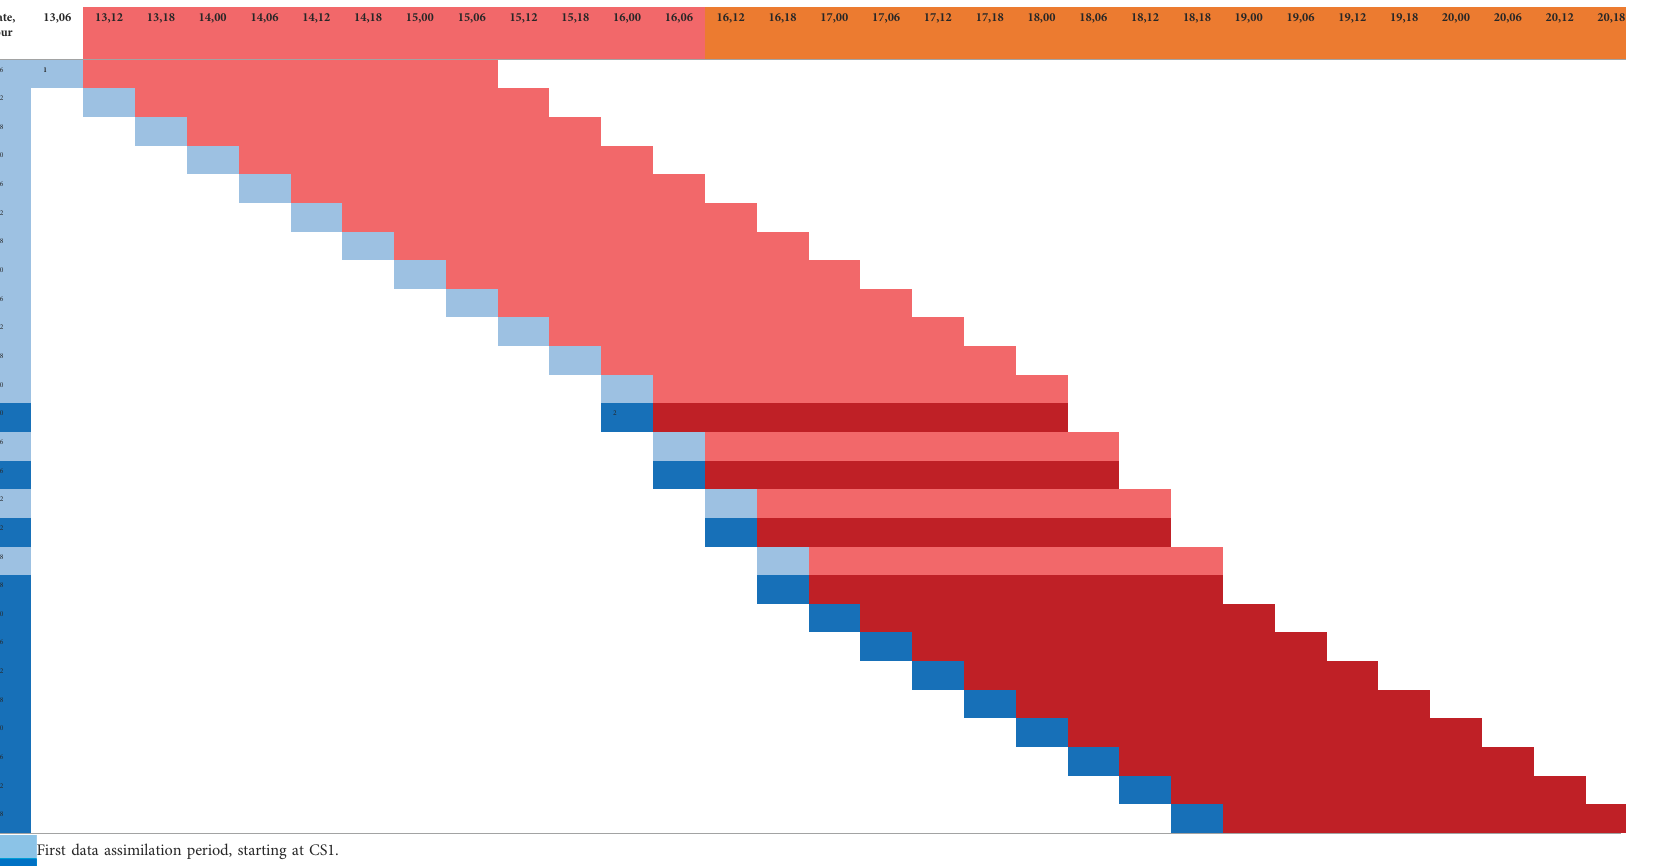
First data assimilation period, starting at CS1. Second data assimilation period, starting at CS2. 48 h of FF, initialized with analysis of the fi rst data assimilation period. 48 h of FF, initialized with analysis of the second data assimilation period. Period with overlapping FF, initialized with analysis from both data assimilation